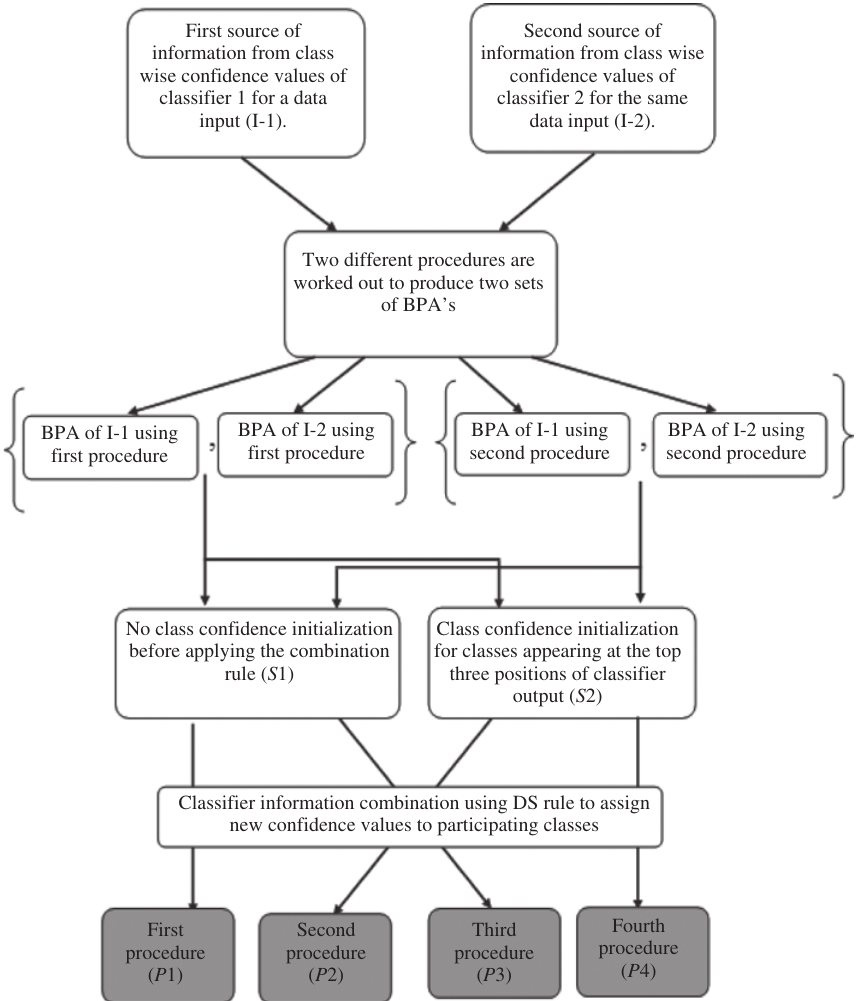
Figure 5: Schematic Diagram of the Four Proposed Procedures Based on DS